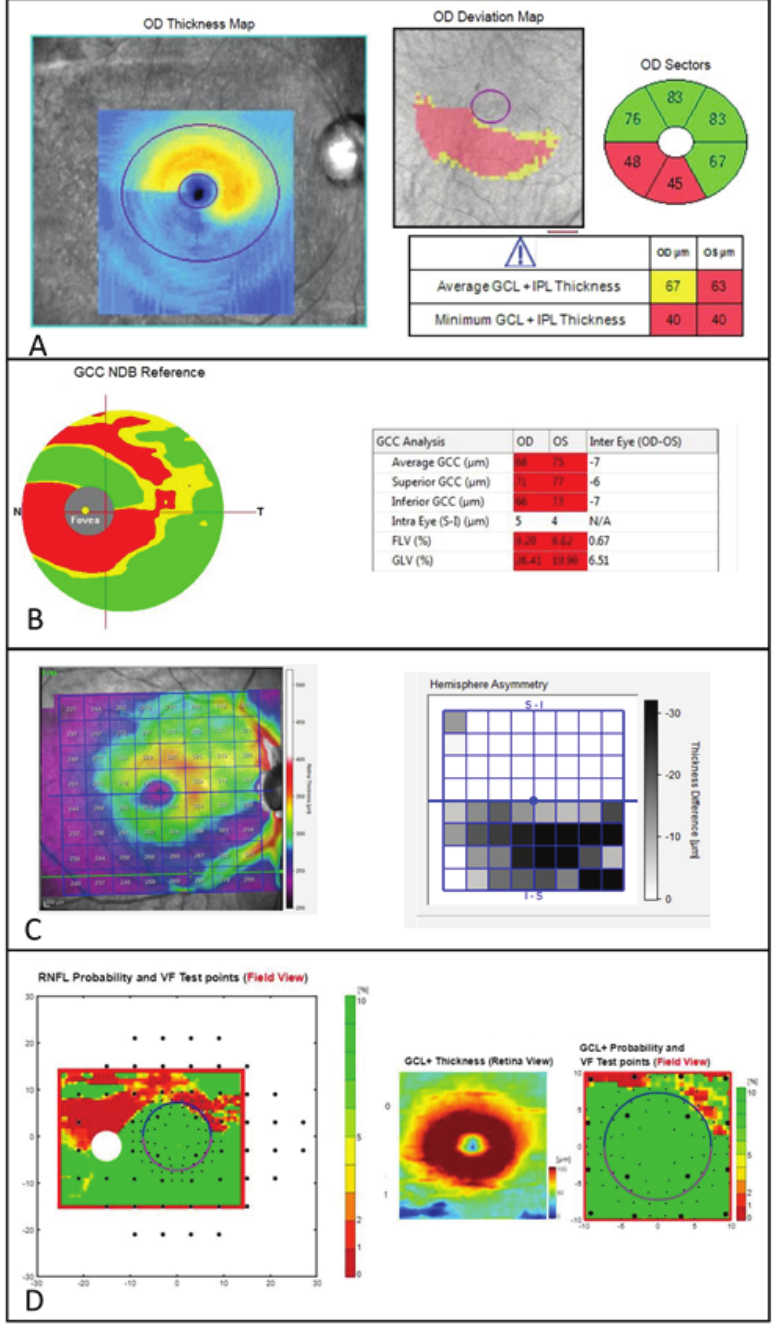
Figure 1. (A) Cirrus HD-OCT Ganglion Cell OU analysis of a patient with glaucoma. Thickness Map, Deviation, Sector Map, and average/minimum GCIPL can be provided by Cirrus OCT. Various types of optic neuropathy, including compressive optic neuropathy and ischemic optic neuropathy, can affect the macula and ganglion cell inner plexiform layer (GCIPL). However, in glaucoma, the inferotemporal region is frequently affected first. The temporal raphe sign is an important sign for distinguishing glaucoma from other neuropathies. The temporal raphe sign is positive if there is a horizontal straight line longer than one- half of the inner-to-outer-annulus length on the macular GCIPL thickness map. (B) Optovue ONH/GCC OU report of a glaucoma patient. Ganglion cell complex (GCC) significant map shows thinning of inner macula layers in the inferior regions. Tabular data also provides the average GCC, as well as focal loss volume (FLV) and general loss volume (GLV). (C) Heidelberg Posterior Pole Asymmetry Analysis Report: Thickness of whole retina as well as individual layers will be shown on an 8 × 8 grid and Hemisphere Asymmetry Map. Thinning of inferotemporal macula is evident in both maps. (D) Topcon Wide Glaucoma report provides GCIPL data (GCL+) or GCC data (GCL++, not shown) in the macula and optic nerve and can be combined with VF results (Hood Glaucoma